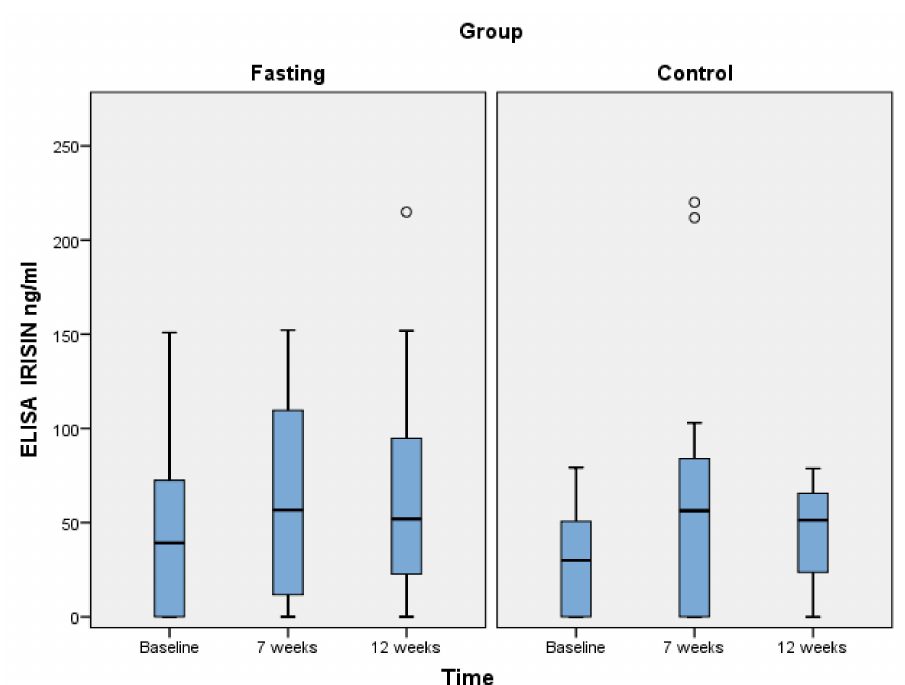
Figure 1. Differences between parathyroid hormone and irisin concentrations in the entire study population at baseline, 7, and 12 weeks. Abbreviations: Fasting: Orthodox fasting group; Control: Time-restricted eating